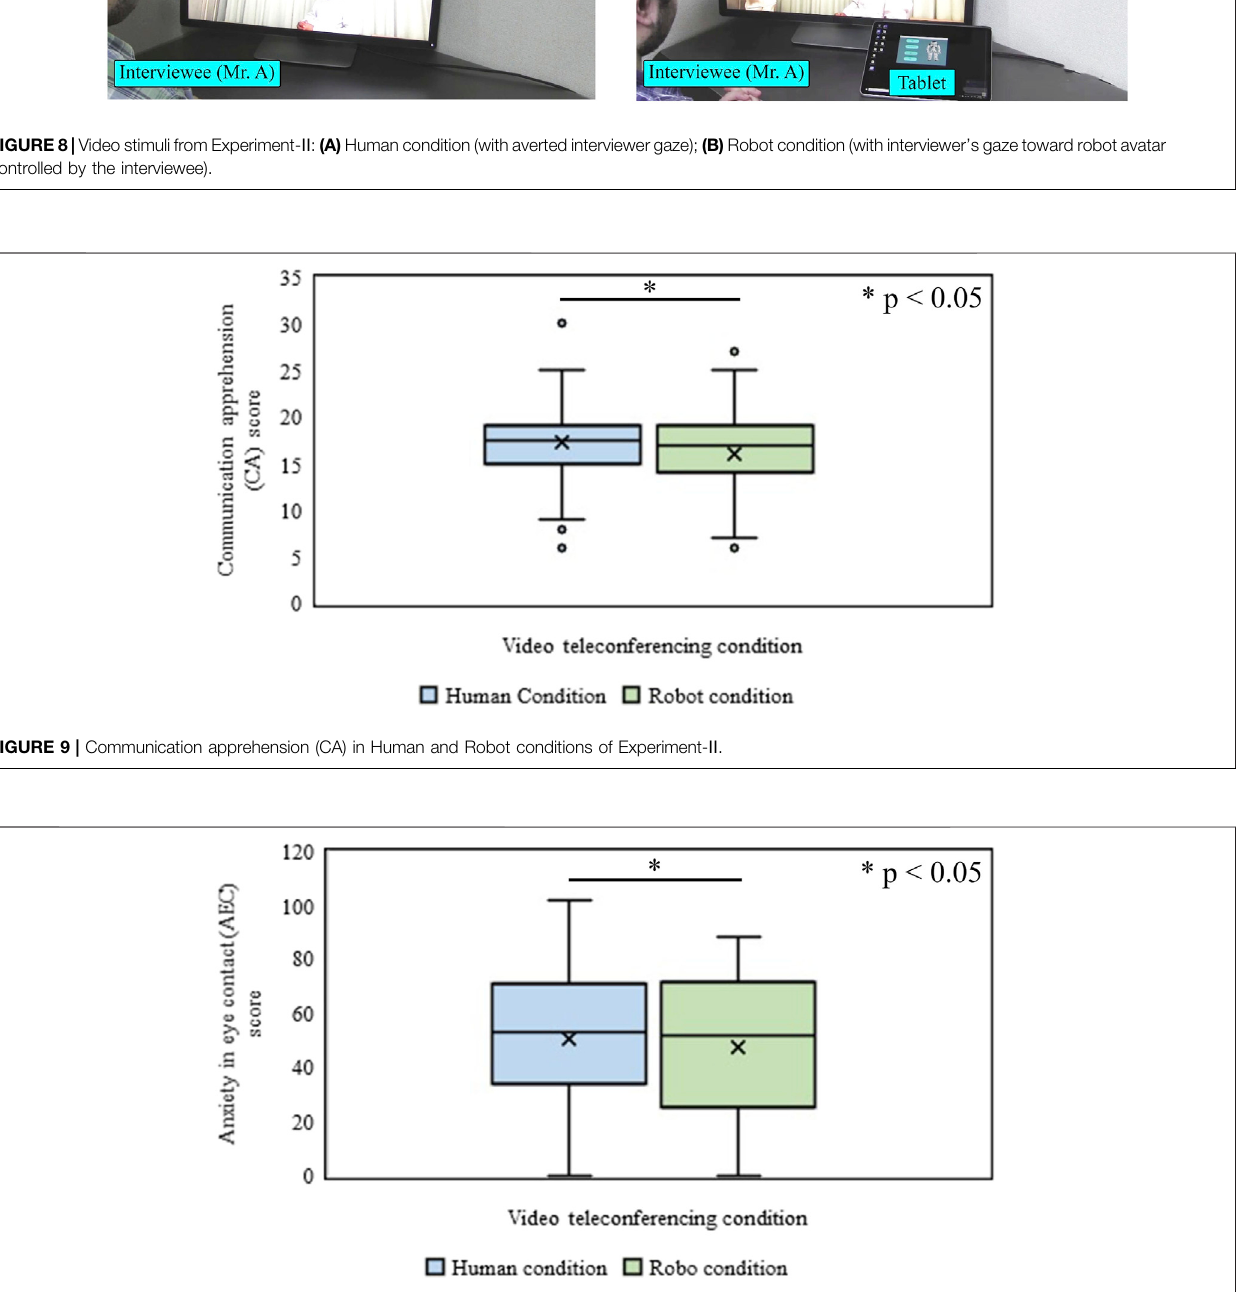
FIGURE 10 | Anxiety in eye contact (AEC) in Human and Robot conditions of Experiment- Ⅱ .